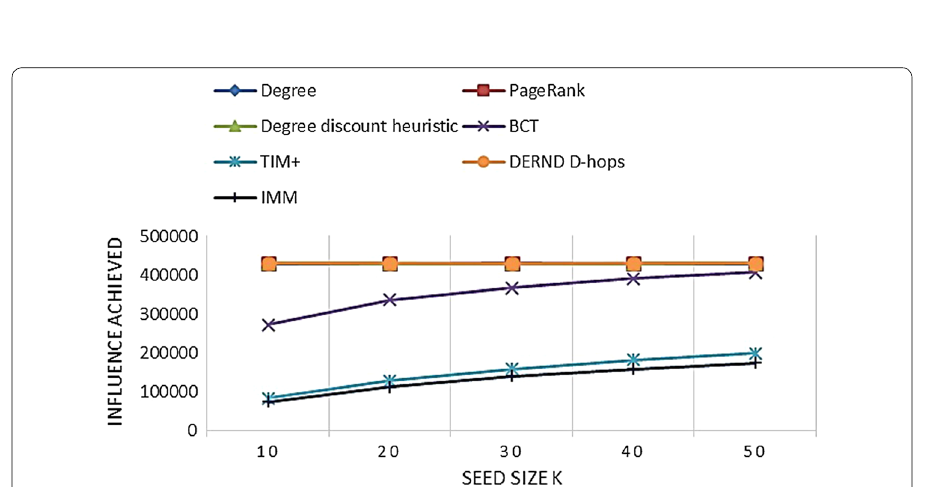
Table 6 Runtime of algorithms on netphy data for K Algorithm